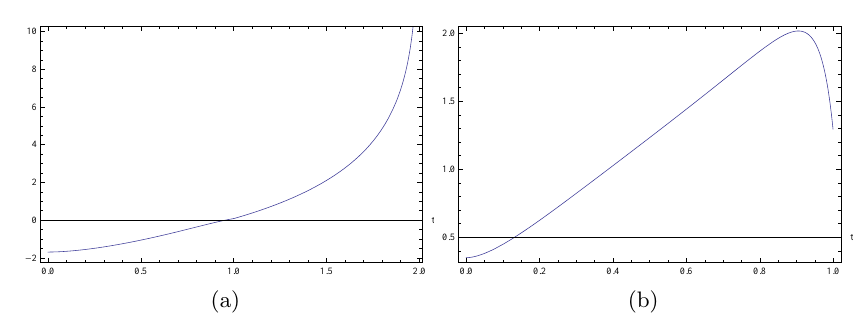
Figure 4 { (a) V 1 : 1 ; 1 : 2 ( X ; t ) Vs t; (b) V 1 : 1 ; 1 : 2 ( X 1: n ; t ) Vs t when n = 10 :